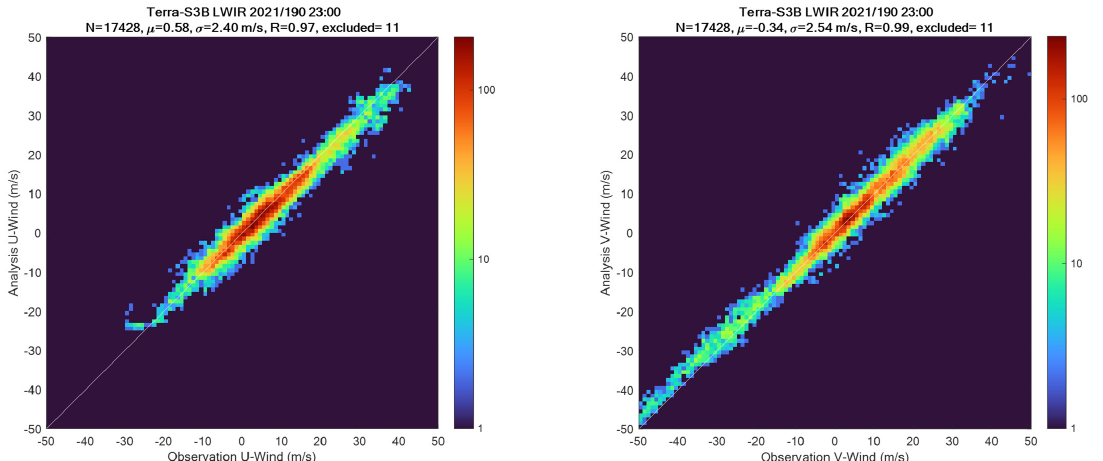
Figure 13. Collocated ERA5–stereo-wind comparisons are shown on log-density plots for an Arctic overpass of Sentinel-3B and Terra on 9 July 2021 23:00Z. Statistics (mean ( μ ), standard deviation ( σ ), and correlation (R)) exclude ground points and a small outlier population with >15 m/s difference (11 outliers out of 17,428). Stereo winds that are more likely misclassified ground points, identified as near-surface calm winds in the stereo dataset, are also excluded. Table 3. Ground-point statistics and ERA5 reanalysis comparisons. Velocity ( V ) components are re- solved along ( u , v ) coordinate axes. The means μ and standard deviations σ of each population N are reported for the indicated case.